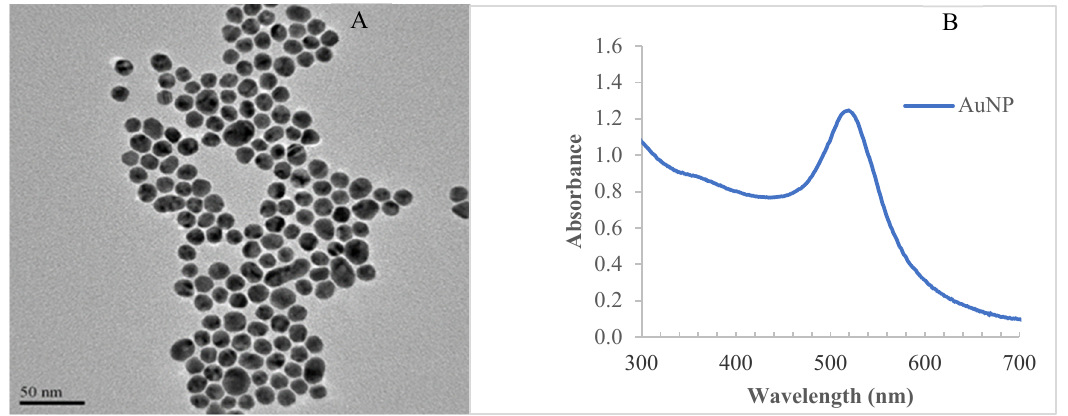
Figure 5. ( A ) A TEM micrograph of the AuNPs. ( B ) The spectra of the AuNPs by UV–visible spectrophotometry.